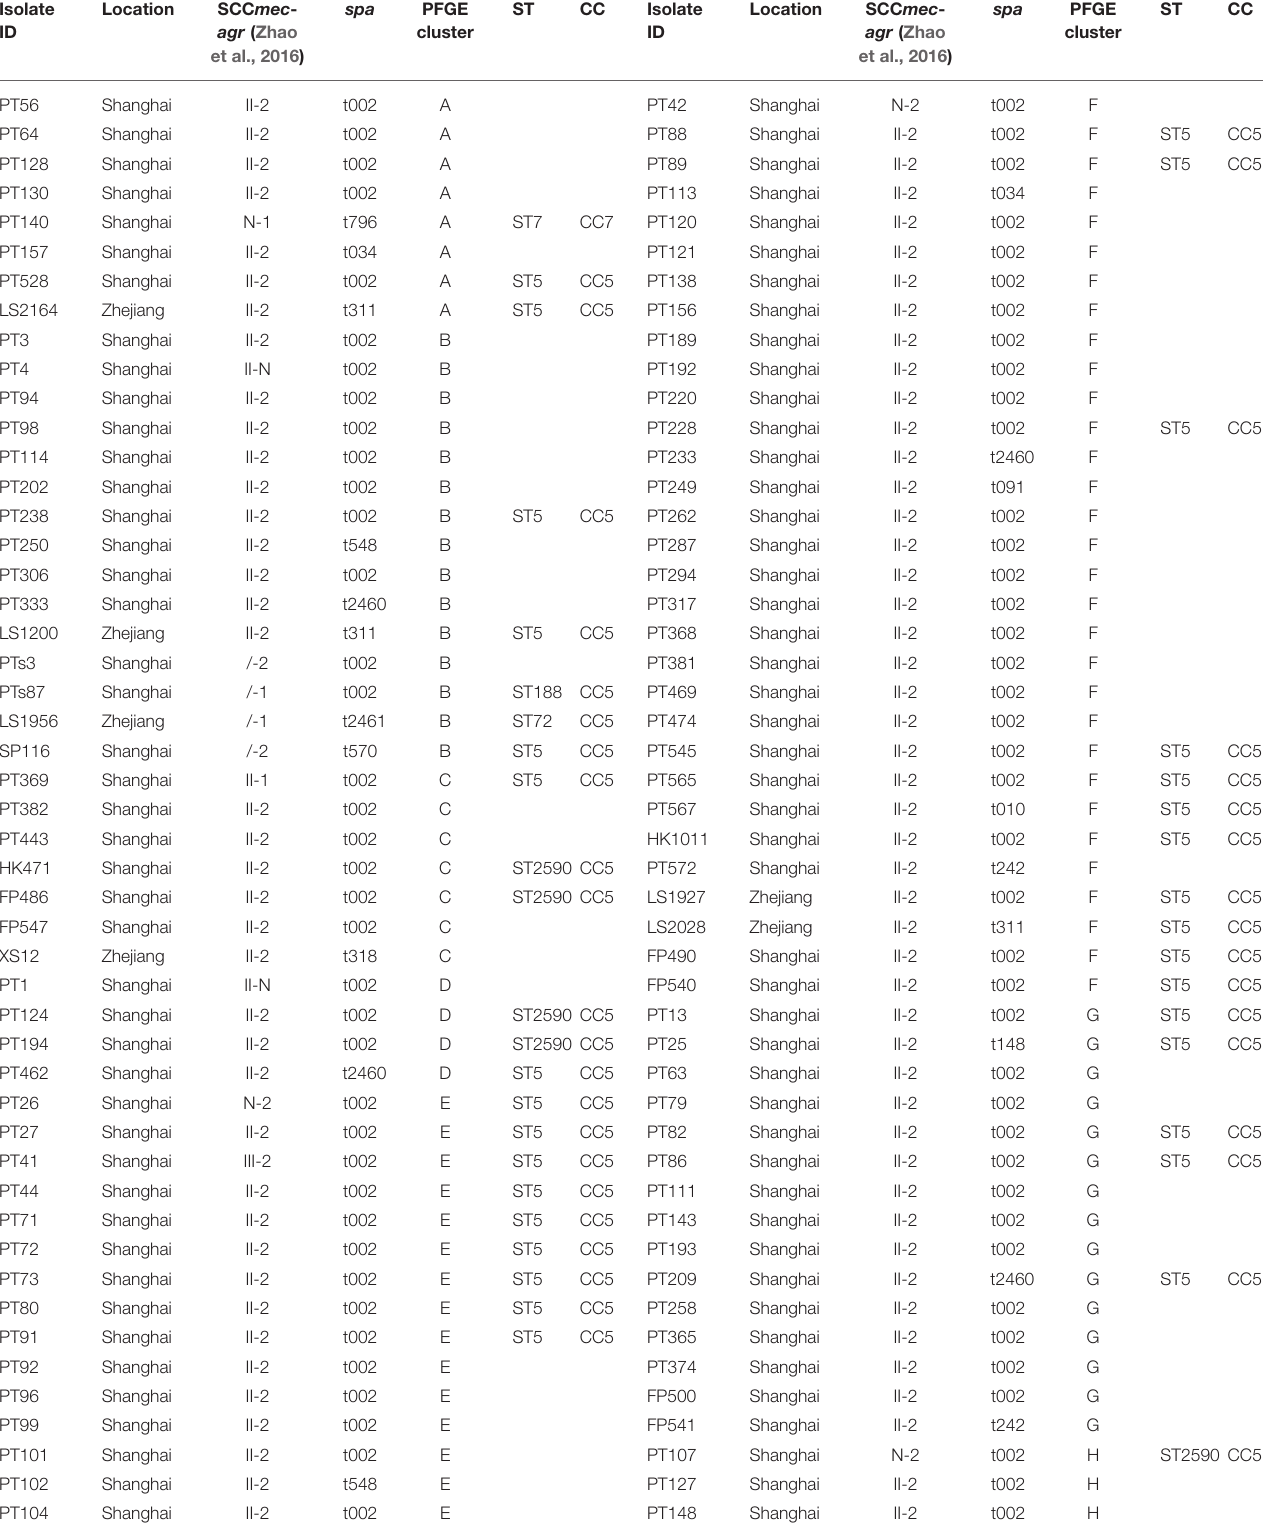
TABLE 2 | Characteristics of 208 tst gene positive S. aureus isolates. Isolate